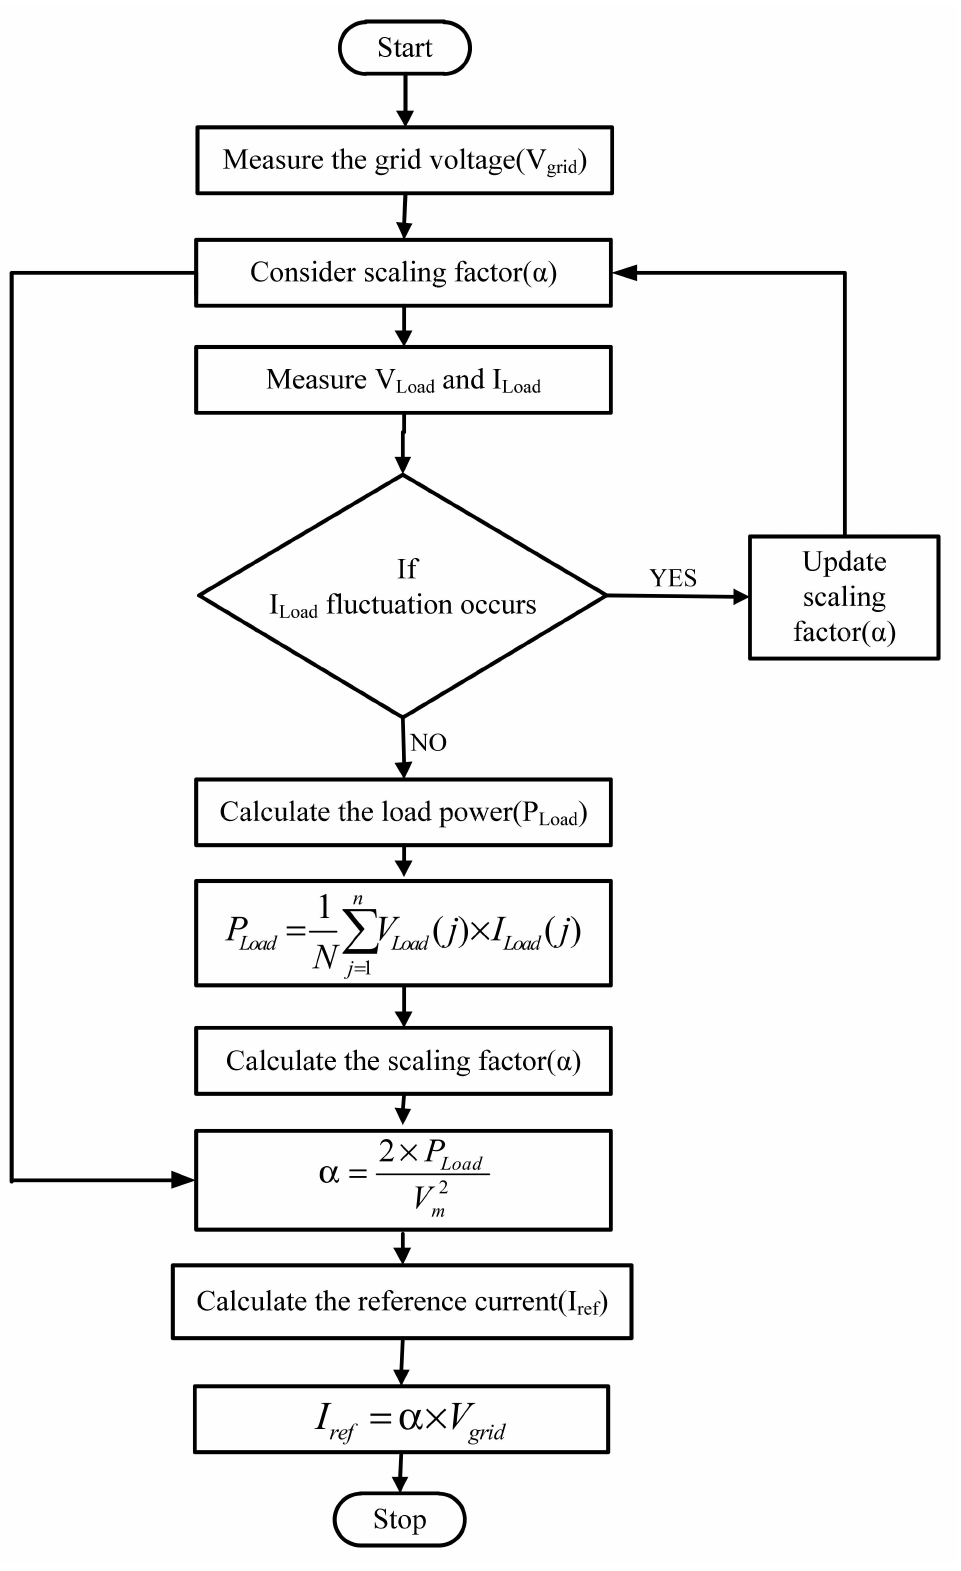
Figure 3. Reference current technique